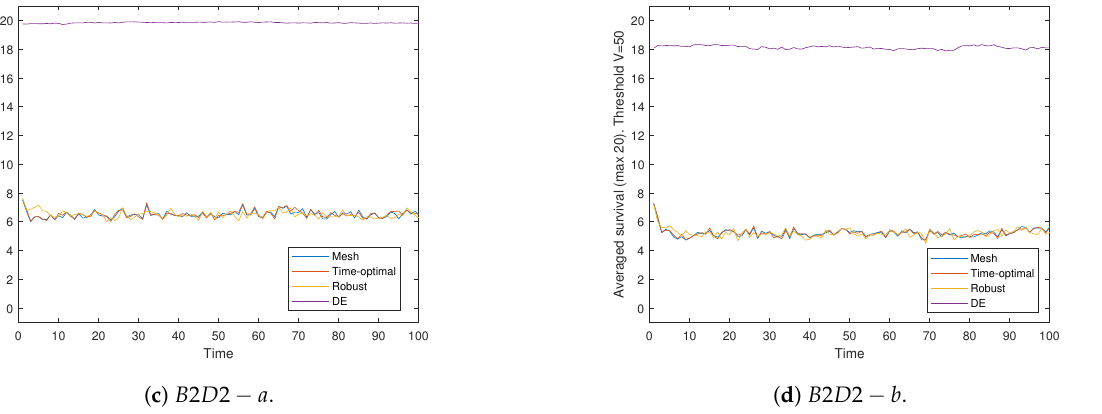
Figure 7. Results obtained using dynamic 2.